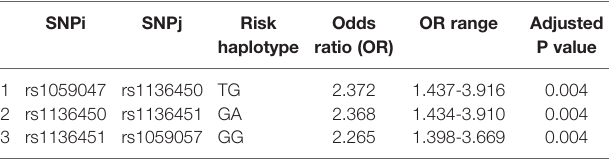
TABLE 6 | Haplotype association with IPF